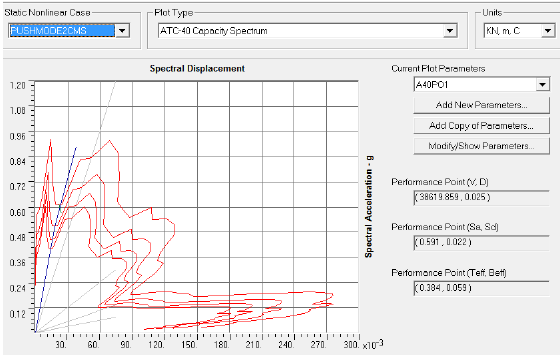
Fig. 16. Capacity spectrum in the longitudinal direction for Kobe earthquake Yield Ultimate Performance Displacement displacement, displacement, displacement, ductility mm mm mm